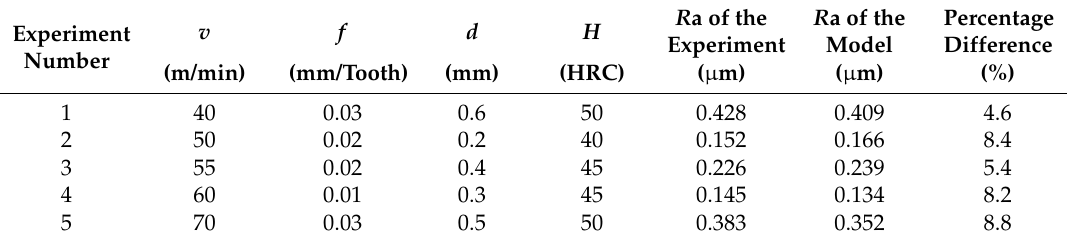
Table 13. The result of validation